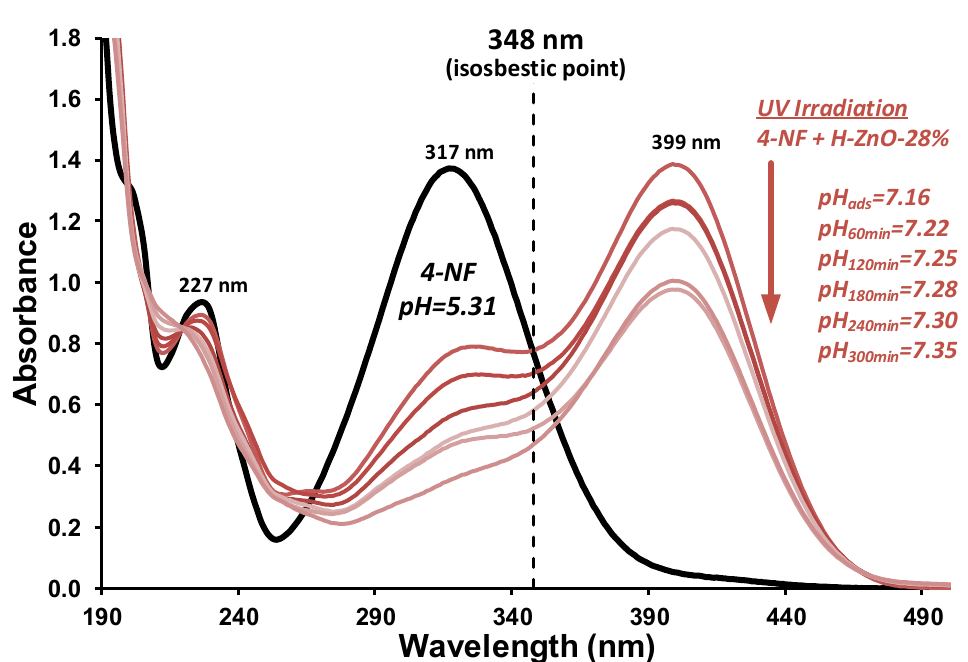
Figure A5. Representative UV-Vis spectra at different irradiation times and change of the pH values of the 40 ppm 4-nitrophenol test compound and the H-ZnO-28% composite after adsorption (0 min) and upon 60–300 min λ max =365 nm UV irradiation. The 348 nm isosbestic point, utilized for the determination of decomposition, is indicated with a dashed line.